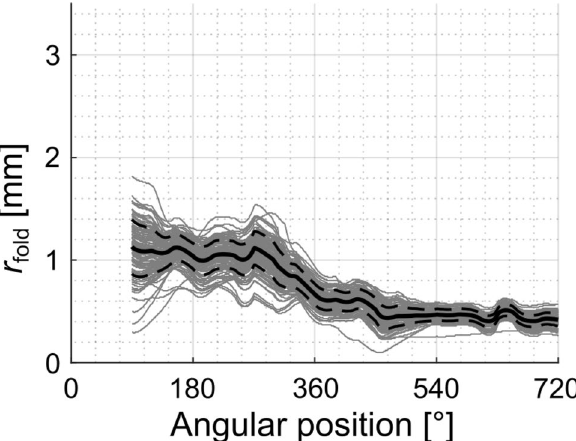
Figure 9. The critical radii ( r fold ) as determined from the 108 corrosion casts. The data reveal a rather flat function until 270°, with mean value of 1.13 mm and maximum values of up to 1.8 mm within the basal cochlear region. Around angular positions of 360°, the critical radii decline to < 0.7 mm.